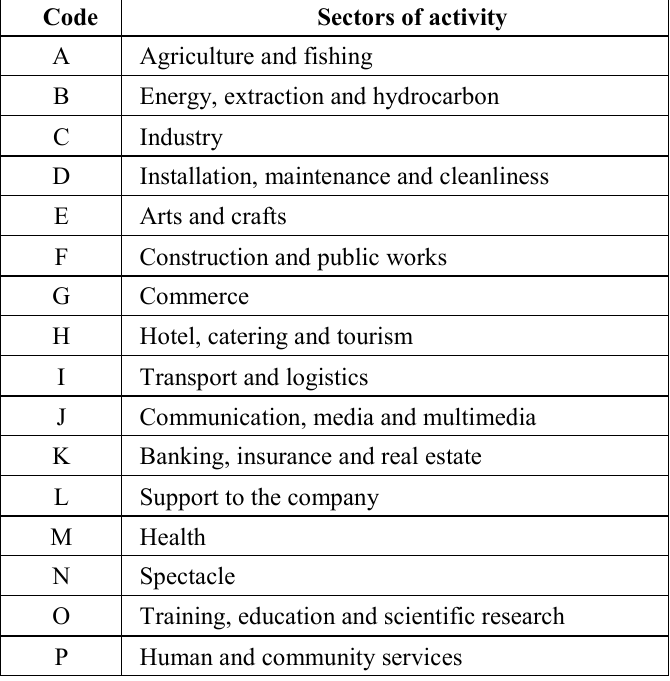
Fig. 1. Path of the trades on the ANTP (ANTP Platform, author’s treatment, 2020). The sectors of activities of the ANTP platform correspond to the economic sectors, namely, the primary sector, the secondary sector and the tertiary sector (administration and services) as shown in Table 2. Table 2. Sectors of Activity of the ANTP